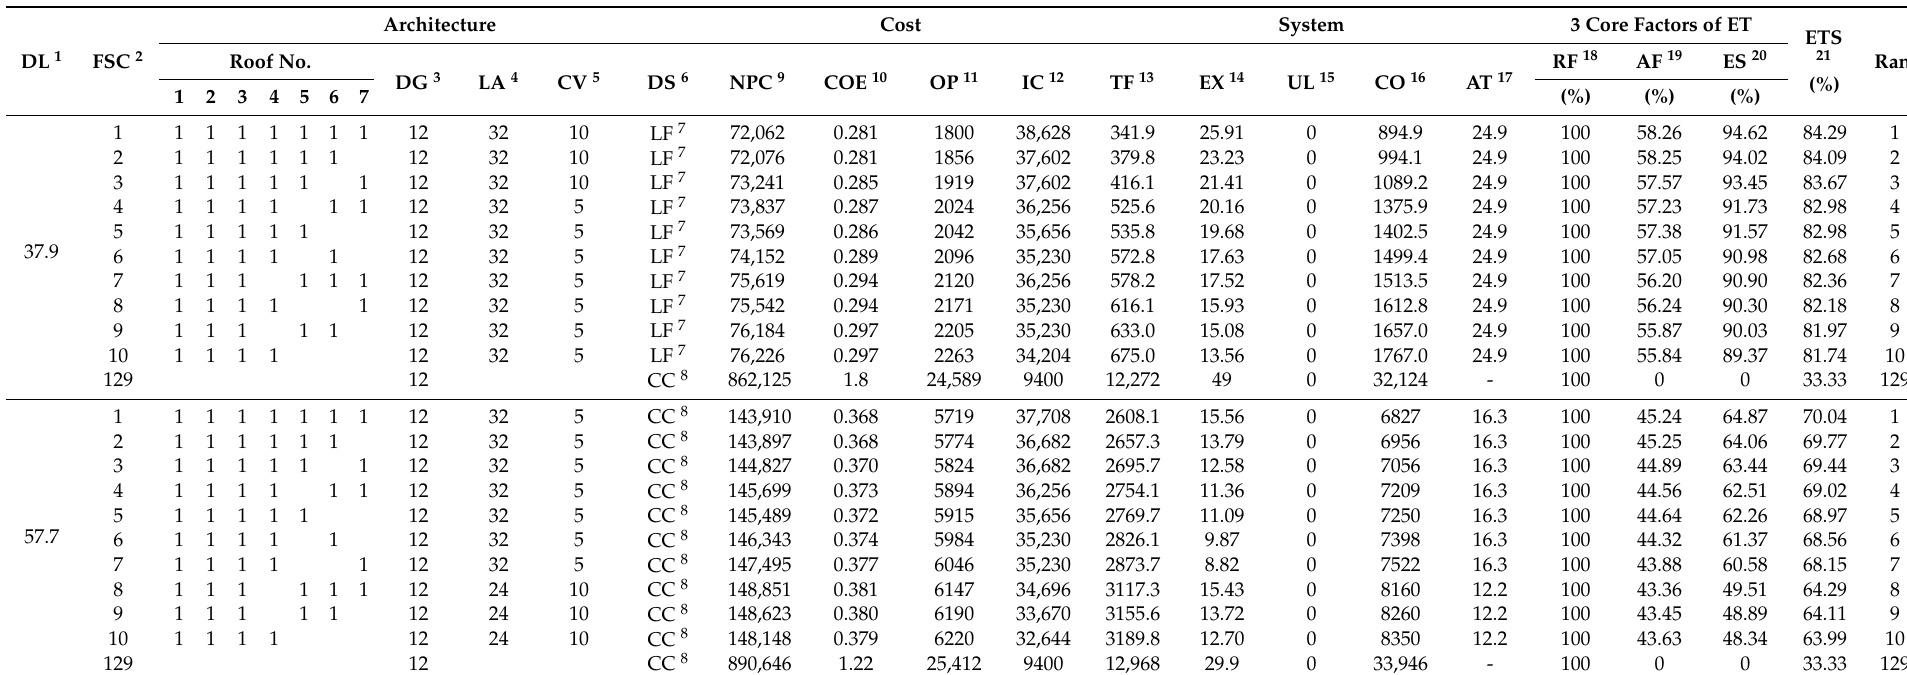
Table 11. Optimization results of the top 10 FSCs and the conventional DG alone based on the ET scoring at 37.9 and 57.7